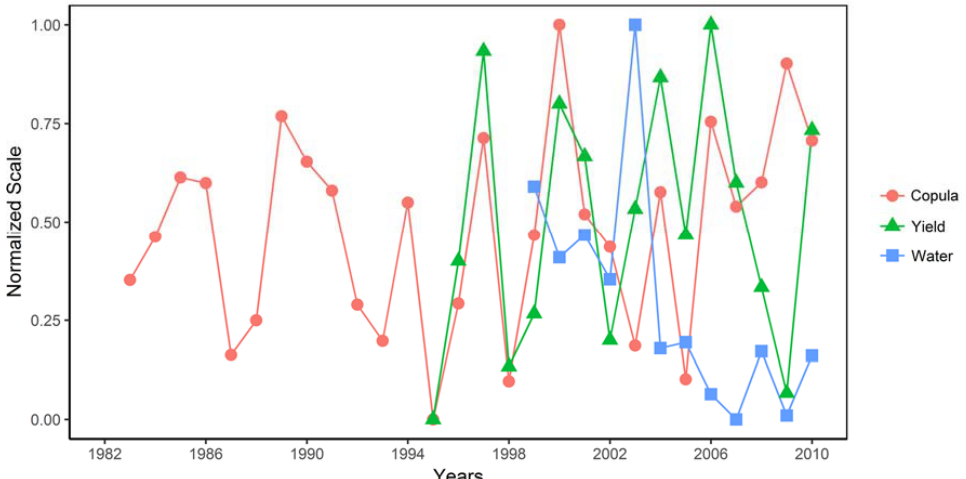
Figure 6. Temporal copula frequency signal in comparison with the validation datasets of millet/sorghum yield and water consumption from central-northern Namibia. The time series were normalized from 0 (copula: unfavorable, yield: low, water consumption: low) to 1 (copula: favorable, yield: high, water consumption: high).